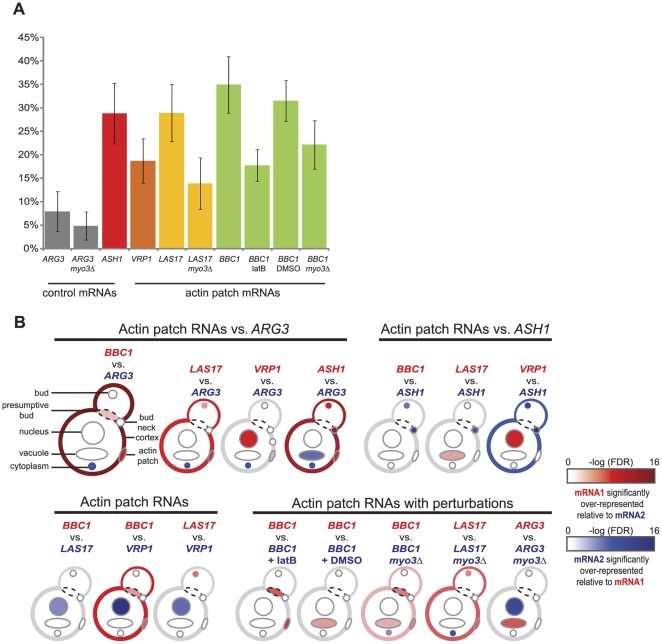
Quantification of actin patch nucleator mRNA localization.(A) Proportion of total mRNAs localizing to the actin patch from cells at all stages of the cell cycle. Error bars represent the 95% confidence interval. (B) Comparison of mRNA localization patterns for pairs of MS2-tagged mRNAs. Cellular structures scored for mRNA localization are indicated in the first ideogram. Significant differences in localization between mRNAs of interest to cellular locations in the ideograms are indicated by color: red or blue indicates a –log false discovery rate (FDR) of 2 (light color) to 16 (saturated, dark color), with red colors indicating significant over-representation of mRNA 1 in each pair and blue colors indicating significant over-representation of mRNA 2. Grey or white represents no significant difference in the localization between the two mRNAs. Significance was measured by Fisher's exact test with the Benjamini-Hochberg multiple hypothesis test correction.